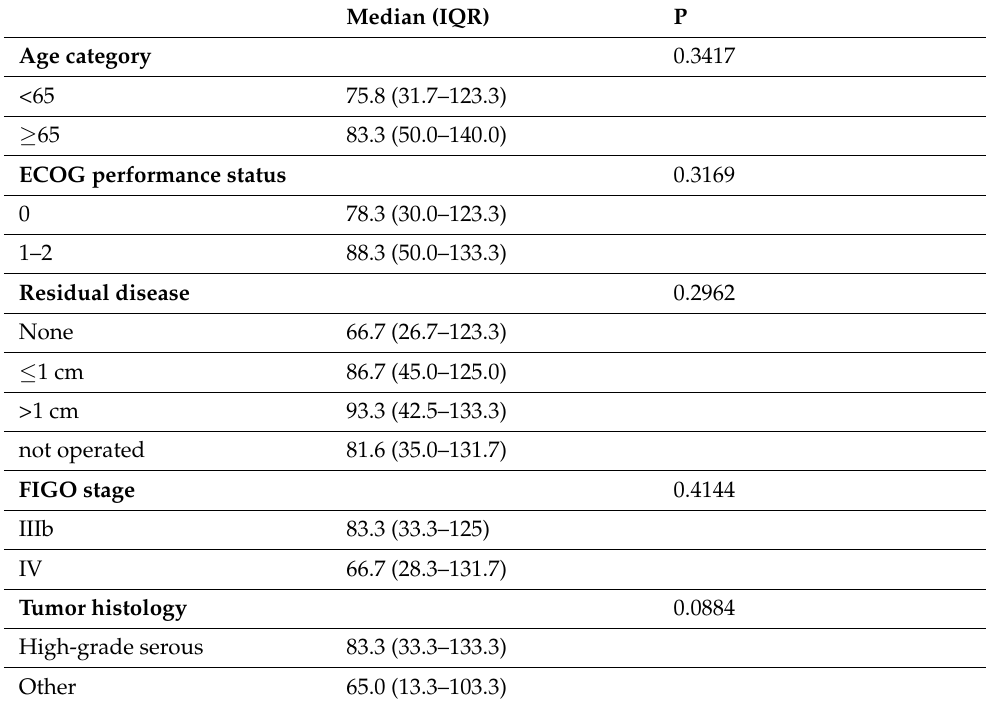
Table 2. Association between ADAM17 expression and baseline characteristics of patients and